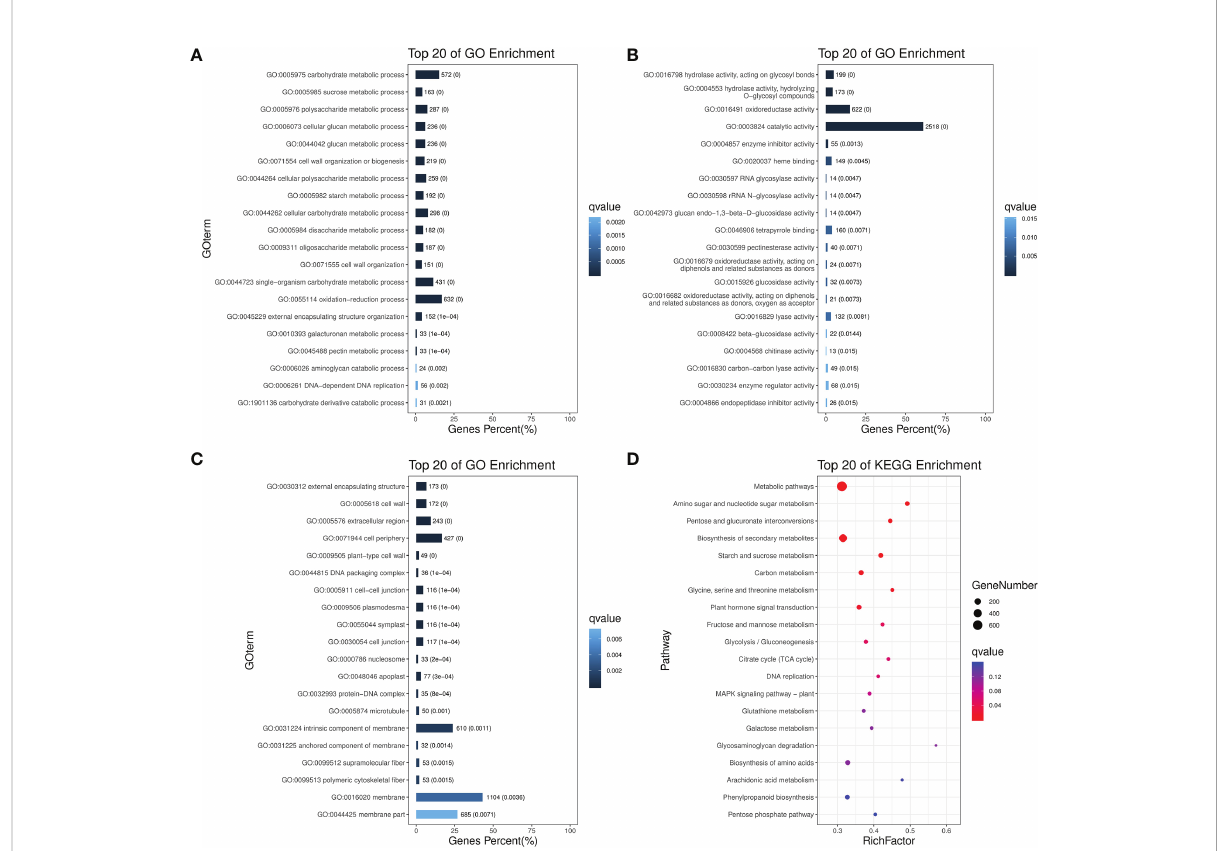
FIGURE 2 GO and KEGG enrichment analysis for non-redundant DEGs after pollination. Top 20 enriched terms are shown for GO enrichments in (A) Biological process. (B) Molecular function. (C) Cellular component; as well as (D) KEGG pathway